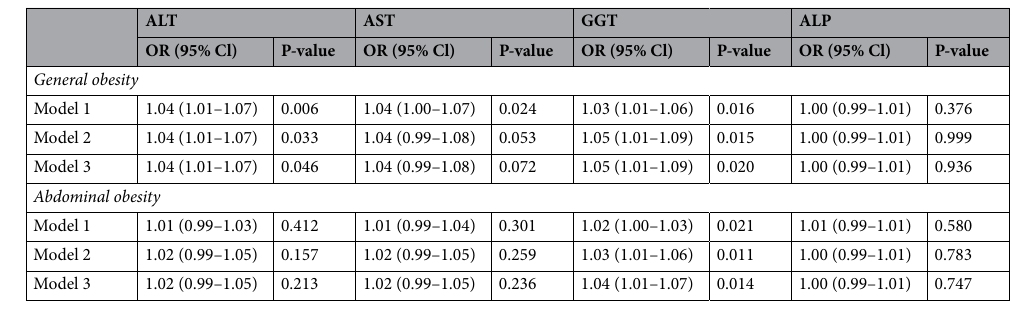
Table 4. Association of liver enzymes with general and abdominal obesity. Multivariate logistic regression analysis was done to assess the relationship of liver enzymes with general and abdominal obesity Dependent variable is obesity (yes) and independent variable is liver enzymes (U/L). Reference category is normal (non- obesity). Model 1: adjusted for age (years) and sex (male and female). Model 2: model 1 + TG and TC (mg/dL). Model 3: model 2 + smoking status, and physical activity. OR, odds ratio; CI, confidence